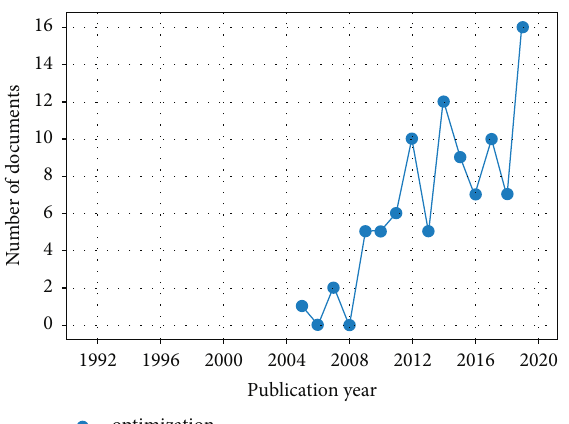
Figure 7: Integrated timeline graph for publications with decision- making or decision making as keywords during the period